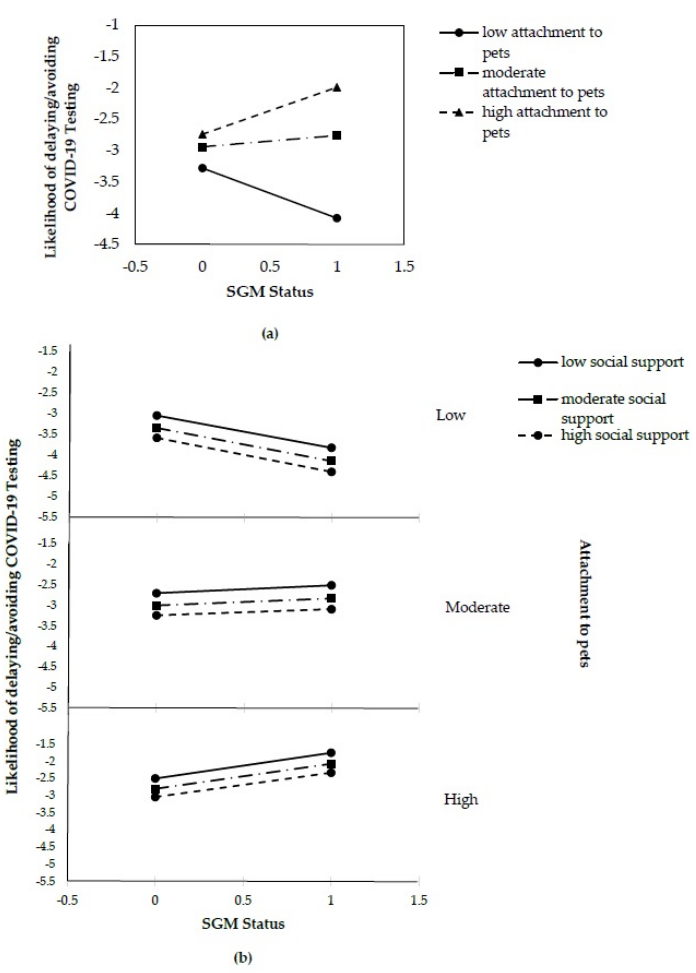
Figure 2. Significant conditional effects of simple and additive multiple moderation analyses ( N = 1453). ( a ) Conditional effect of SGM status on the likelihood of delaying or avoiding COVID-19 testing as a function of attachment to pets. ( b ) Conditional effect of SGM status on the likelihood of delaying or avoiding COVID-19 treatment as a function of attachment to pets and social support.